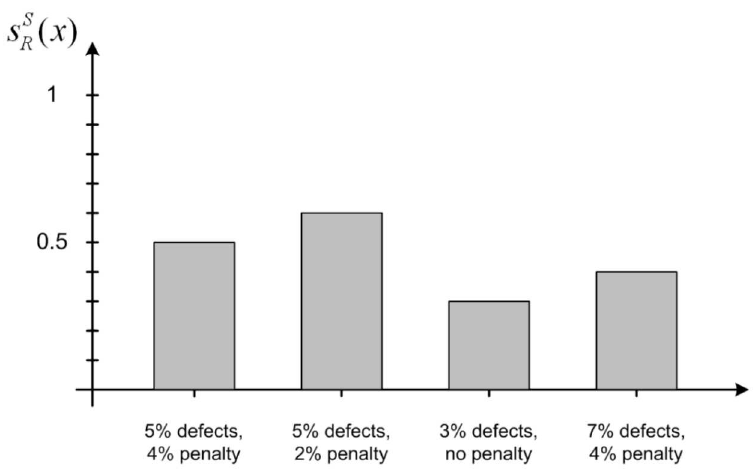
Figure 6. The Seller’s membership function for returns